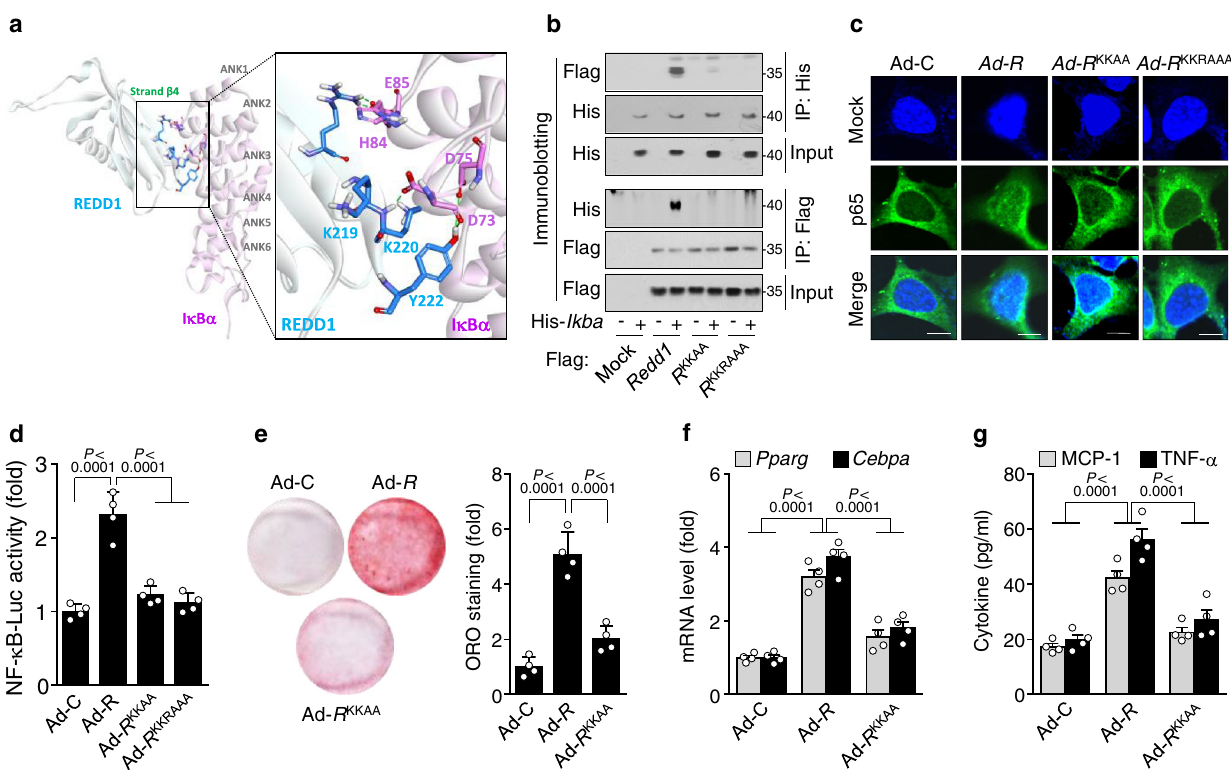
e Representative ORO-stained images of 3T3-L1 cells infected with Ad-control, Ad- Redd1 , or Ad- Redd1 KKAA and quanti fi cation of relative ORO intensity ( n =4). f Expression levels of Pparg and Cebpa in 3T3-L1 cells infected with Ad-control,Ad- Redd1 , or Ad- Redd1 KKAA ( n =4). g Production of MCP-1 and TNF- α in macrophages infected with Ad-control, Ad- Redd1 , or Ad- Redd1 KKAA ( n =4). Bar graphs represent mean ± s.e.m. Statistical signi fi cance was calculated using one-way ANOVA ( d , e ) and two-way ANOVA ( f , g ) followed by the Holm – Sidak post hoc test. Source data are provided as a Source Data fi